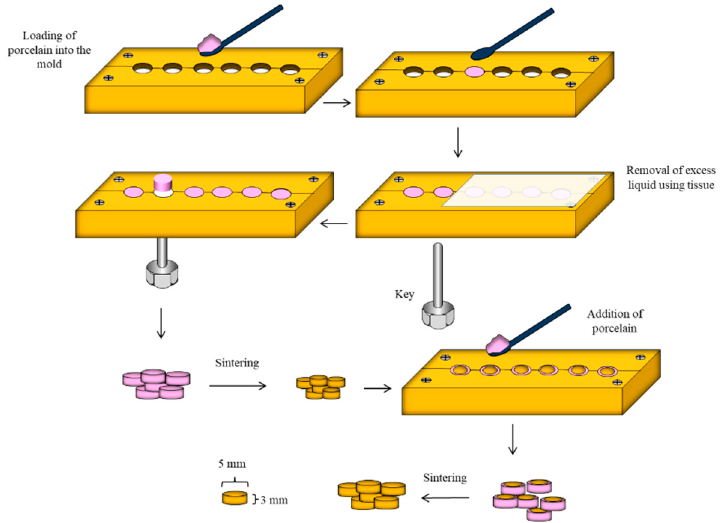
Figure 3. Schematic diagram showing detailed steps of VITAVM TM 13 porcelain specimens’ preparation.